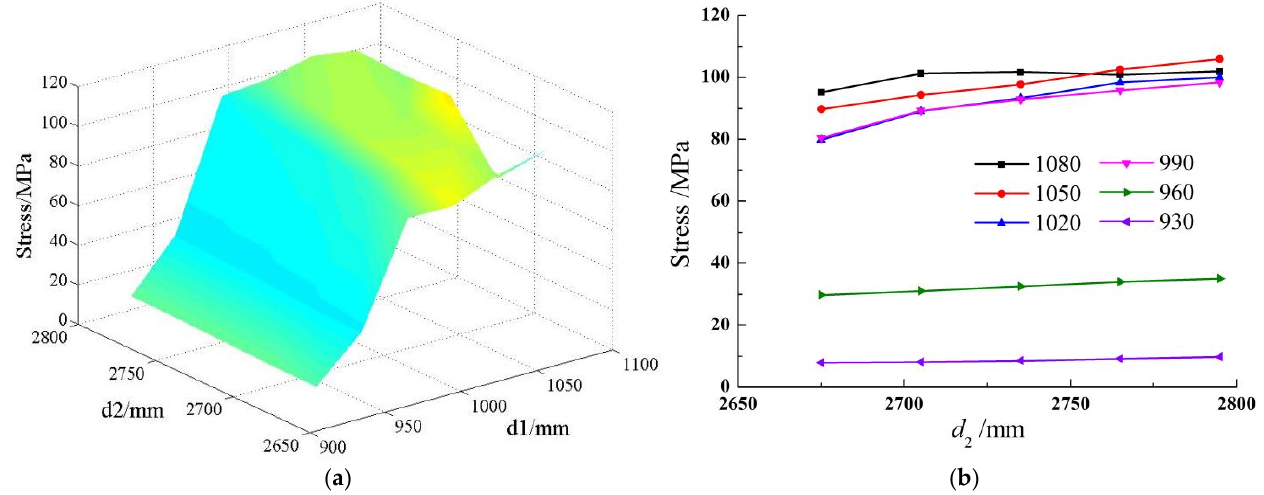
Figure 9. The interior reinforcement nodal stress graphics of weld 1. ( a ) Three-dimensional graphic, ( b ) Two-dimensional graphic.